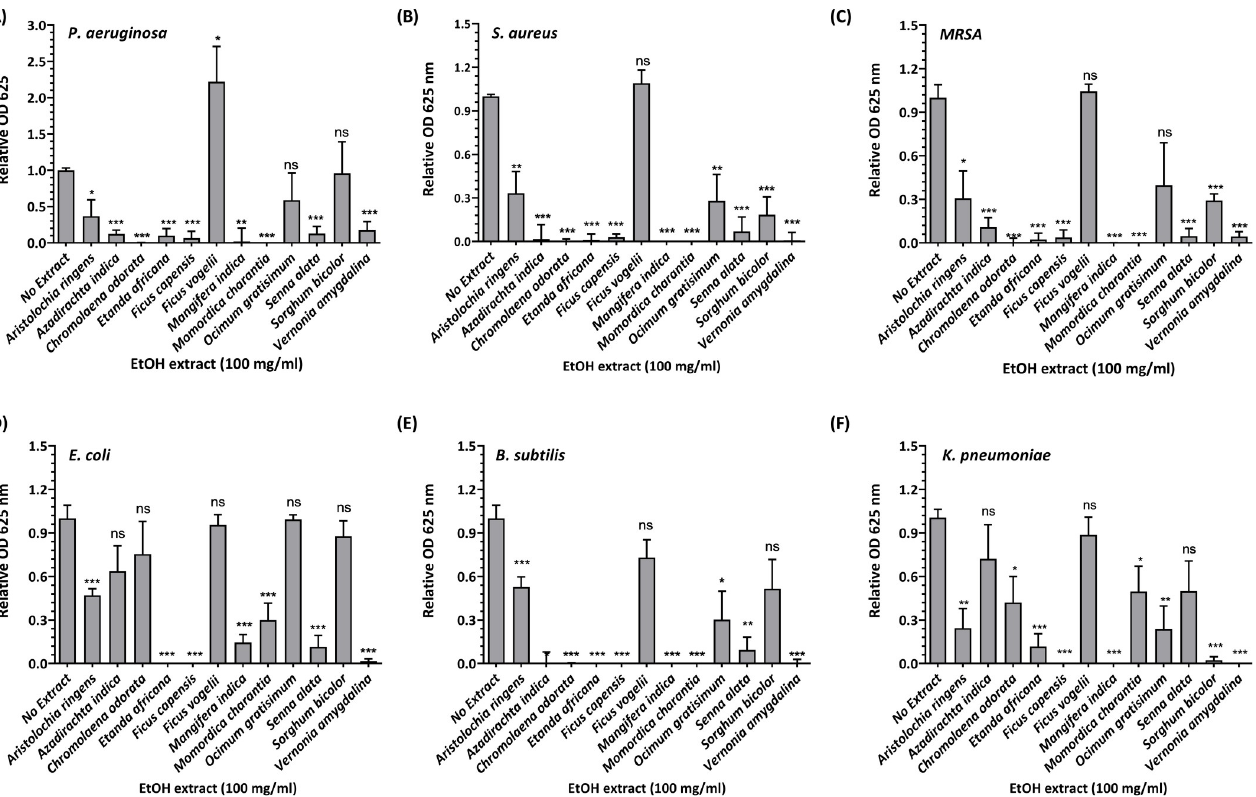
Fig 2. Bacterial inhibition by plant ethanolic extracts. Duplicate wells of 96 well microplates were seeded to a final volume of 250 μ l comprising 25 μ l plant ethanolic (EtOH) extract, 8.5 μ l bacteria and 216.5 μ l nutrient broth. Plates were incubated at 37˚C with shaking at 140 rpm for 18 hours. Bacterial growth is shown as spectrophotometric (OD λ = 625 nm) measurement of media turbidity measured against pre-incubation reads. Each panel shows the relative OD of treated samples compared to non-treated samples of (A) P . aeruginosa , (B) S . aureus (C) MRSA (D) E . coli (E) B . subtilis , and (F) K . pneumoniae (n = 2 ± S.E.M., ns = not significant, � p < 0.05, �� p < 0.01, ��� P <